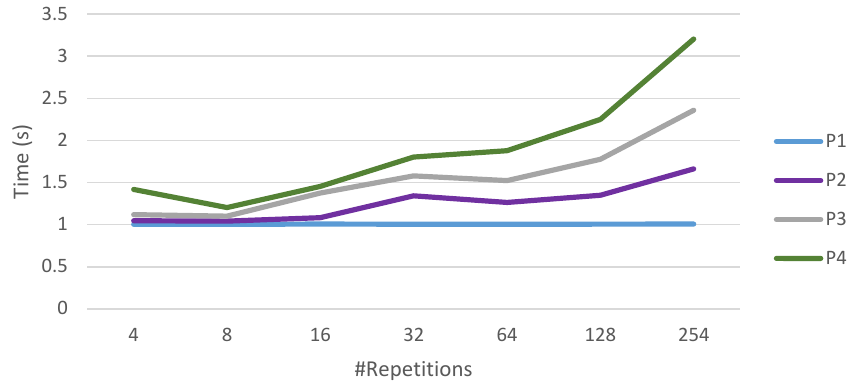
Figure 16. Effect of repetition on packet